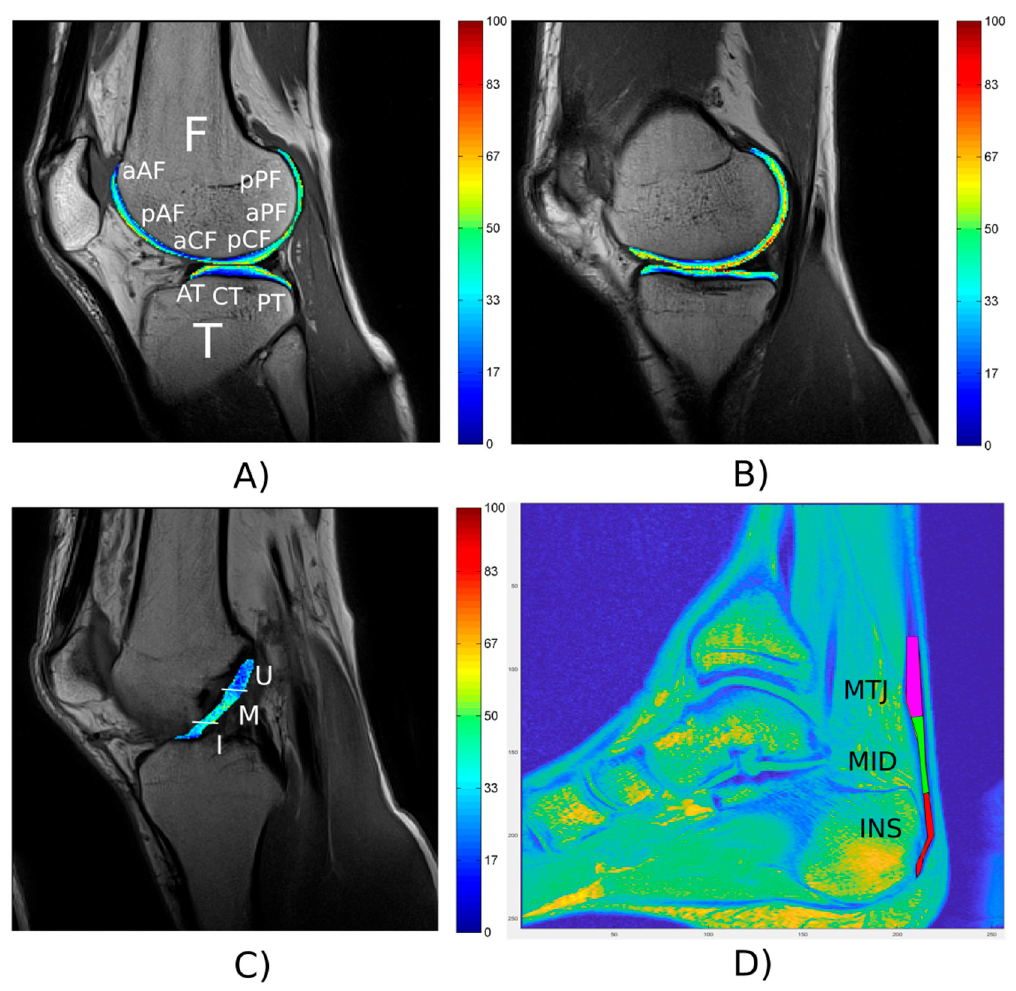
Figure 7. Representative T2 relaxation time map of knee articular cartilage and regions-of-interest (ROIs) for the lateral ( A ) and medial compartment ( B ); F—femur, aAF—anterior side of anterior part of femur, pAF—posterior side of anterior part of femur, aCF—anterior side of central part of femur, pCF—posterior side of central part of femur, aPF—anterior side of posterior part of femur, pPF—posterior side of posterior part of femur, T—tibia, AT—anterior part of tibia, CT—central part of tibia, PT—posterior part of tibia. Representative T2 relaxation time map and ROIs of ACL ( C ); Whole ACL, I—insertion, M—mid part, U—upper part). ROIs of AT on sagittal T2*-weighted image ( D ); INS—insertion, MID—middle, MTJ—muscle-tendon